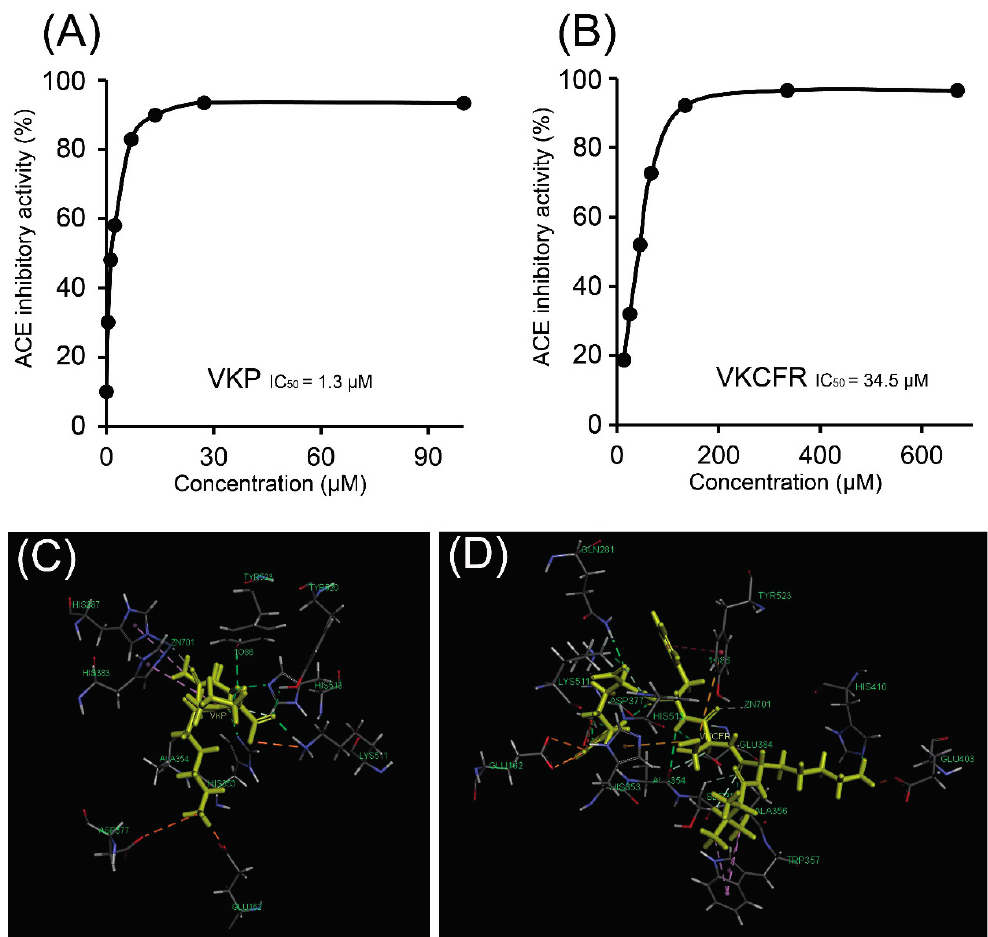
Figure 4. ( A ) ACE inhibitory activity of VKP with IC of 1.3 μ M. ( B ) ACE inhibitory 50 activity of VKCFR with IC of 34.5 μ M. ( C ) Interface overview of optimal docking 50 positions of VKP at the ACE catalytic site. ( D ) Interface overview of optimal